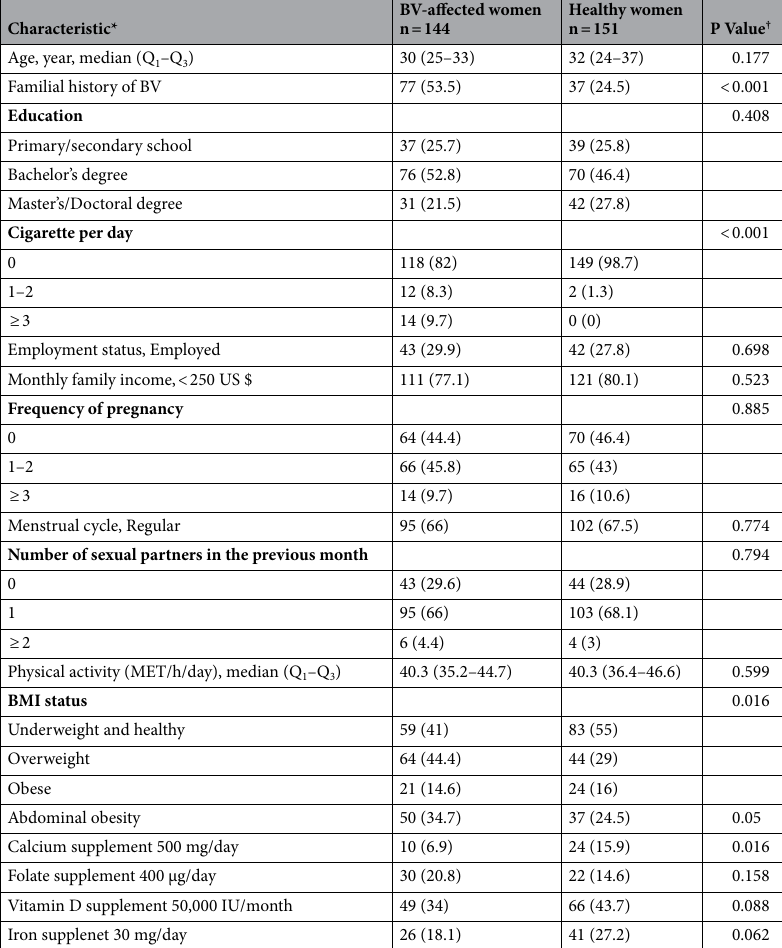
Table 2. Baseline characteristics of participants in case and control groups. BV bacterial vaginosis, BMI body mass index. *Values are No (%) unless otherwise noted. † Using Mann–Whitney U or χ 2 test/Fisher’s excact test, as